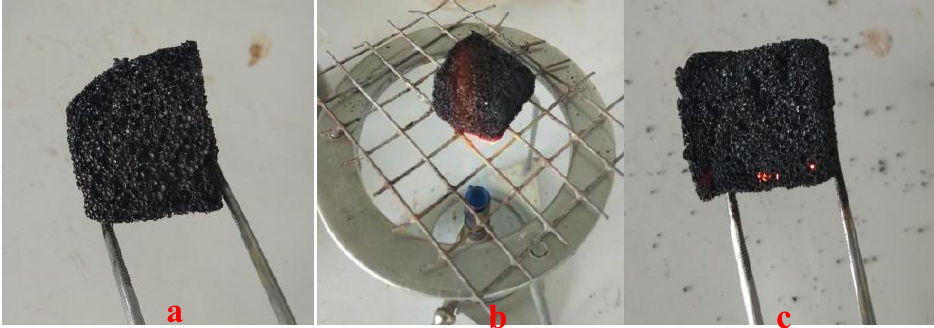
Figure 6. Pictures of ignition test of foam F2: ( a ) before ignition, ( b ) at ignition, and ( c ) after 5 min.